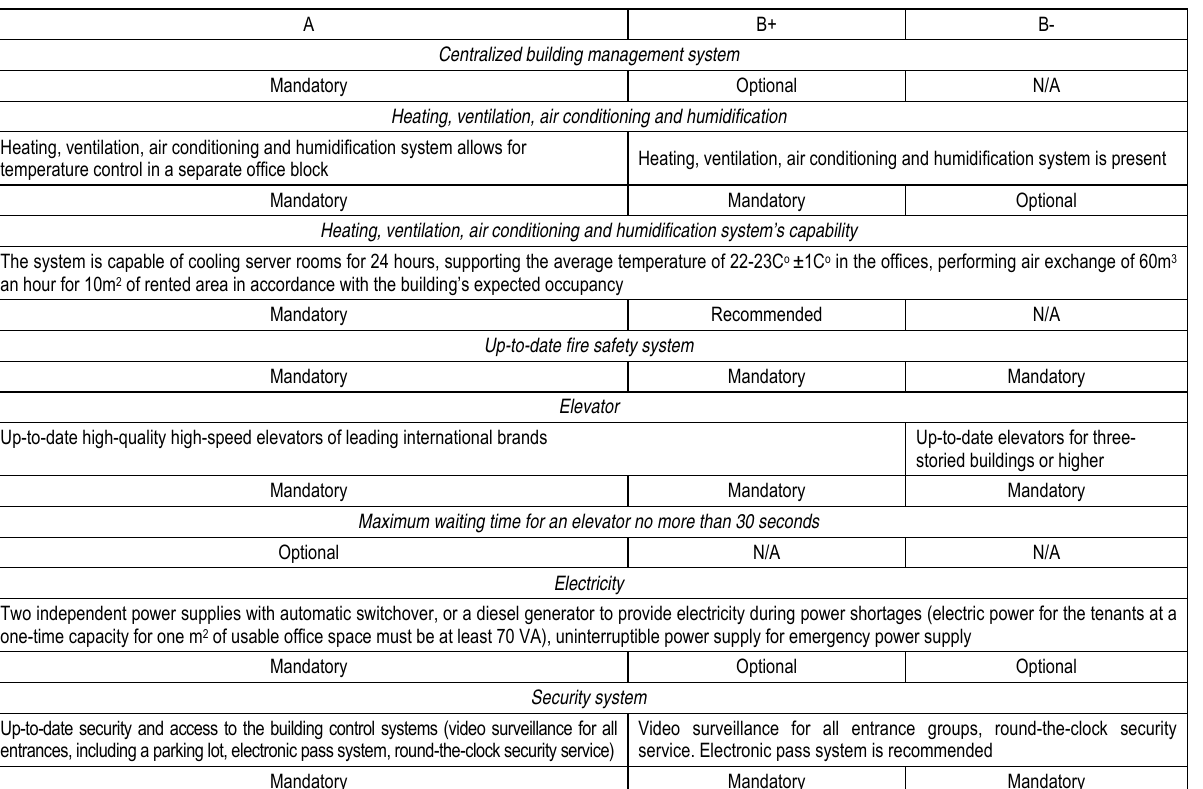
Table 2. Office building classification criteria